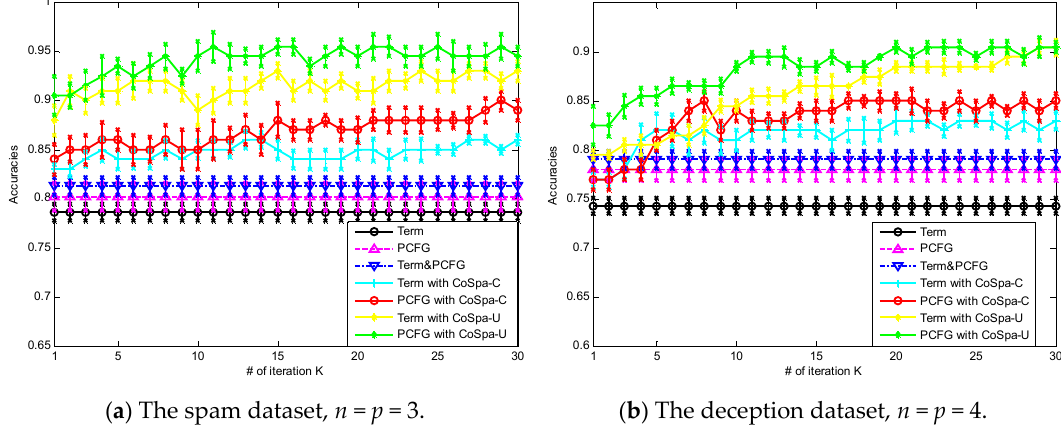
Figure 2. Performances of the CoSpa algorithm with different K compared with the baseline methods. Table 7. The performances on accuracies of the CoSpa algorithm compared with the state-of-the-art methods on spam review identification in the spam and deception datasets.